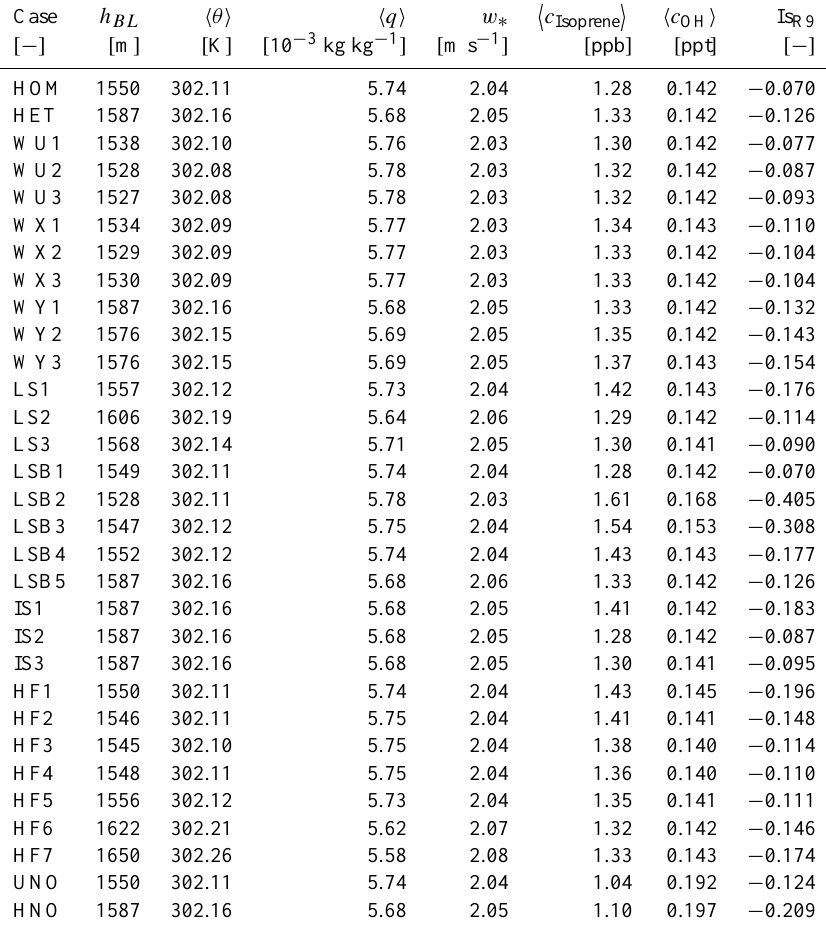
Table 4. Main properties of the different numerical experiments averaged over the fourth hour of simulated time. h BL represents the boundary layer height. h θ i and h q i are respectively the potential temperature and specific humidity averaged over the whole boundary layer. w ∗ is the convective velocity scale. The boundary layer averaged concentrations of isoprene and OH are denoted by respectively (cid:10) c Isoprene (cid:11) and h c OH i . Is R9 is the intensity of segregation for Reaction (R9) (Table